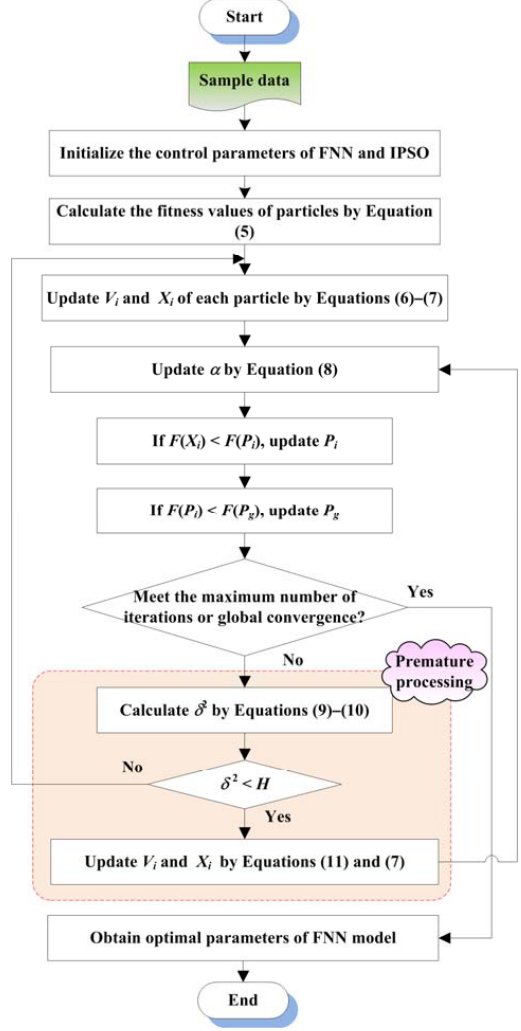
Figure 2. Optimizing the parameters of the fuzzy neural network (FNN) model with improved particle swarm optimization (IPSO).